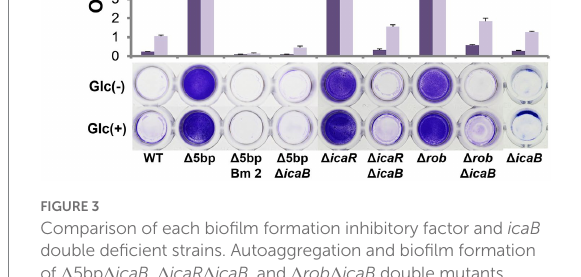
FIGURE 3 Comparison of each biofilm formation inhibitory factor and icaB double deficient strains. Autoaggregation and biofilm formation of Δ 5bp Δ icaB , Δ icaR Δ icaB, and Δ rob Δ icaB double mutants. Autoaggregation assay (A) and biofilm formation (B) of FK300 and FK300 Δ 5bp, FK300 Δ 5bpBm 2, FK300 Δ 5bp Δ icaB , FK300 Δ icaR , FK300 Δ icaR Δ icaB, FK300 Δ rob , FK300 Δ rob Δ icaB and FK300 Δ icaB . Status before and after mixing for a few seconds on a vortex mixer is shown. Each bacterium was cultured in TSB medium at 37 ° C for 6 h with shaking. (B) Bacteria were grown in TSB in the presence (Glc) or absence (Glc-) of 1% glucose. Biofilm formation was measured using the polystyrene microtiter plate assay as described in the Methods section. Bars indicate mean values, error bars indicate standard error of the mean ( n = 3). WT; wild type strain